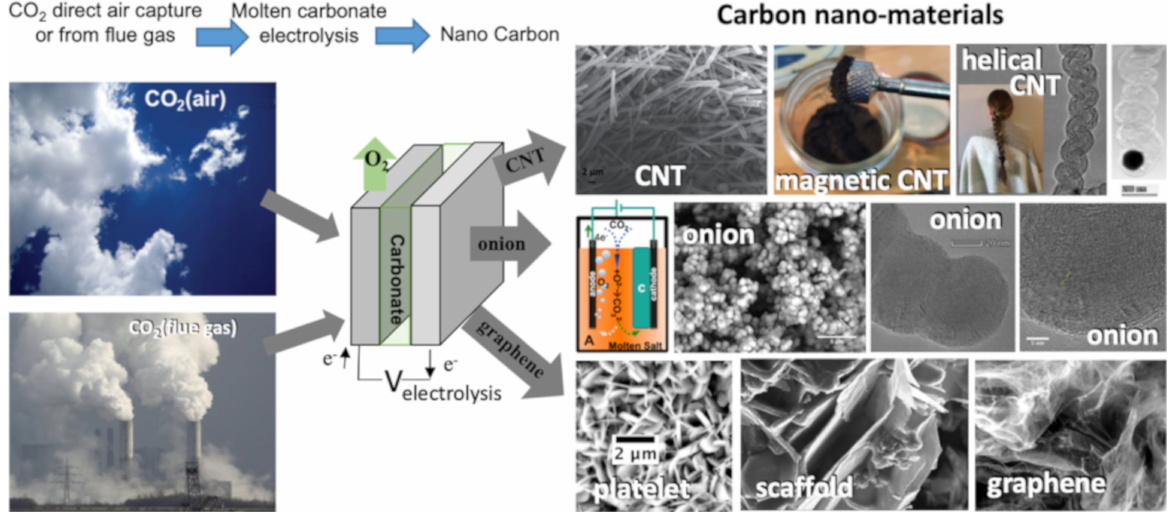
Figure 1. High-yield electrolytic synthesis of carbon nanomaterials from CO 2 , either directly from the air or from smokestack CO 2 , in molten